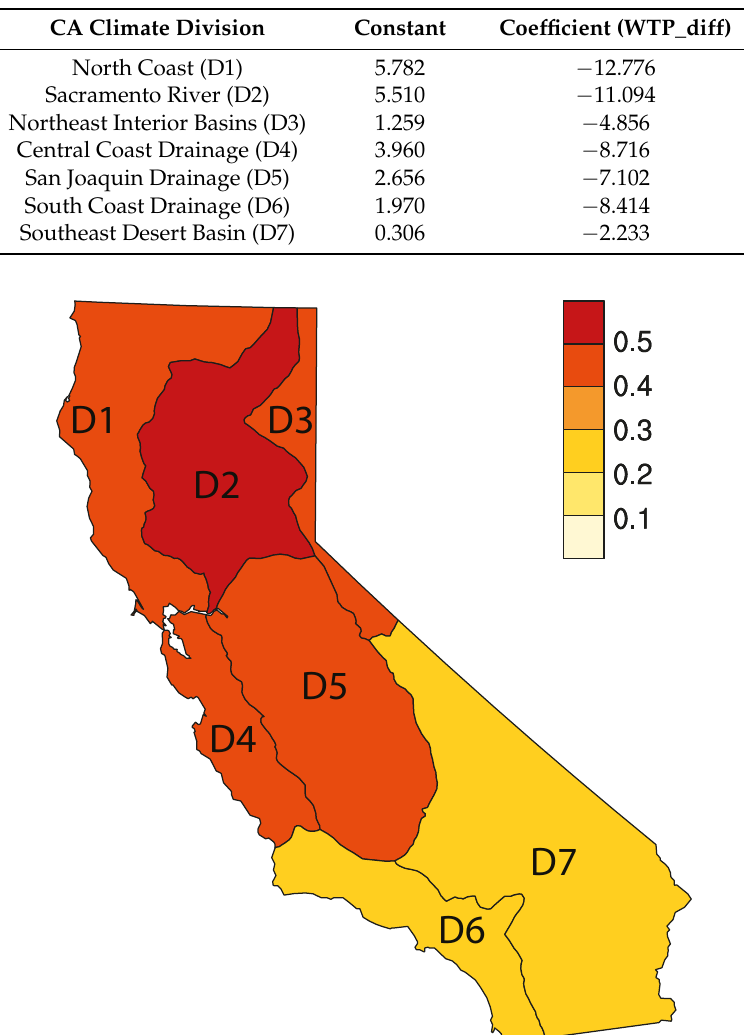
Figure 10. R-squared values for each climate division of CA. Table 5. Linear regression models estimating DJF precipitation in each climate division of CA using WTP_diff for the 21-year (1995–2015) period.